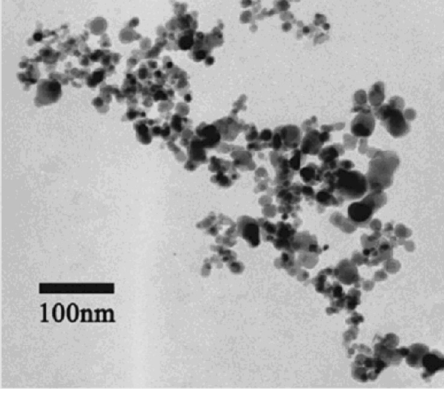
FIGURE 3 - TEM of LTZ-PLGA-NPs with 10%